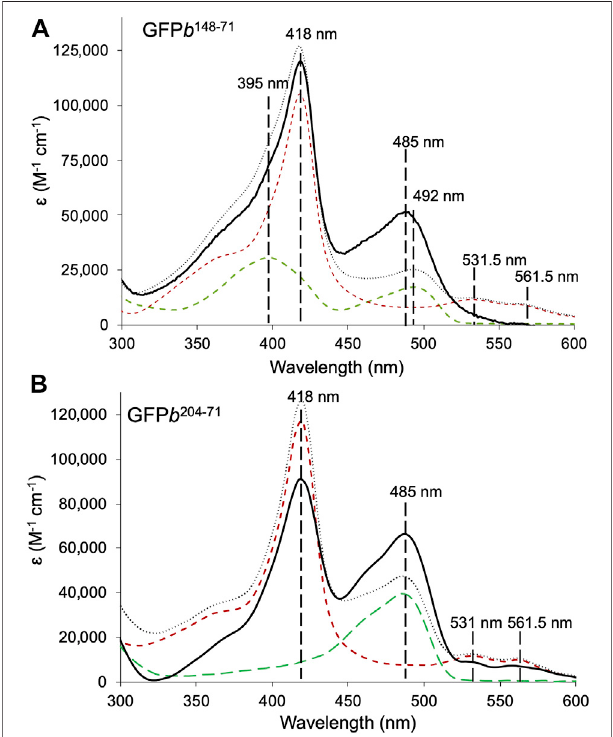
FIGURE 2 | Absorbance spectra of sfGFP-cyt b 562 heterodimers. (A) GFP b 148-71 (black solid line), and constituent monomers sfGFP 148SCO (green dashed line) and cyt b 56271azF (red dashed line). (B) GFP b 204-71 (black solid line), and constituent monomers sfGFP 204SCO (green dashed line) and cyt b 56271azF .Thecombinedsumofeachmonomericabsorbanceisshownfor comparison (grey dotted line). Data shown as molar extinction coef fi cients. The wavelengths associated with the λ max for each monomer absorbance peak is shown for reference. The molar absorbance coef fi cients are shown in Supplementary Table S2